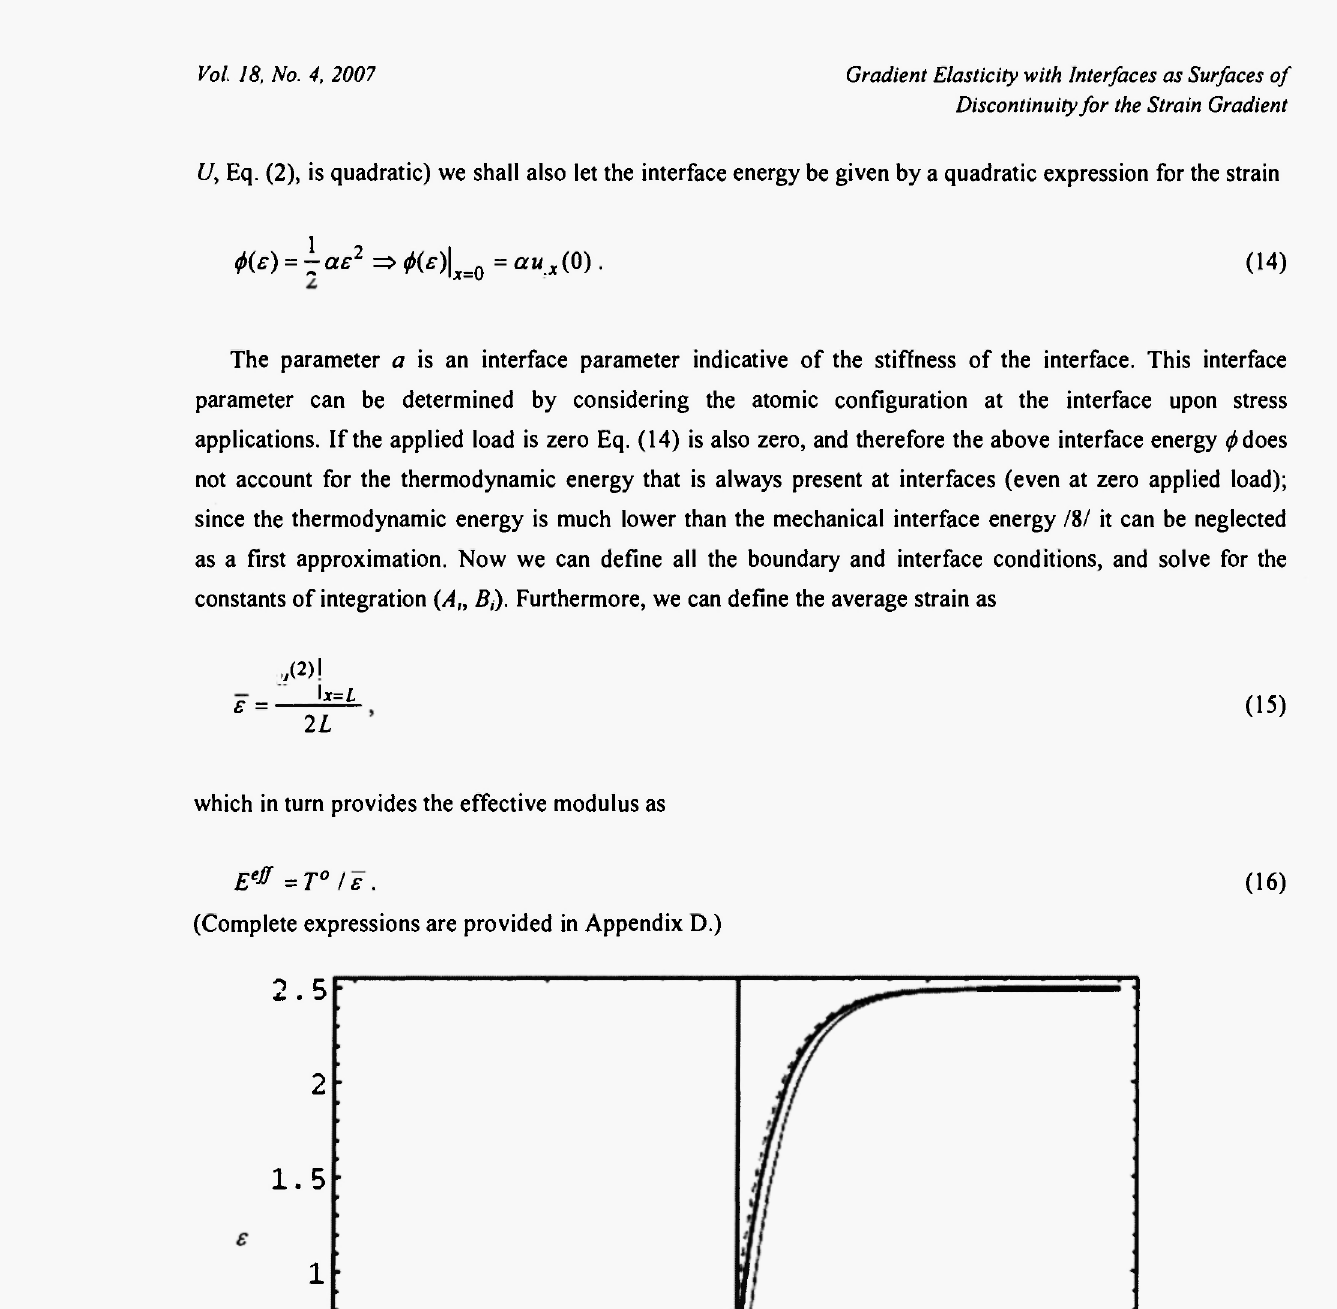
Fig. 2: Strain distribution in bi-crystal. a= 0 corresponds to no interface being